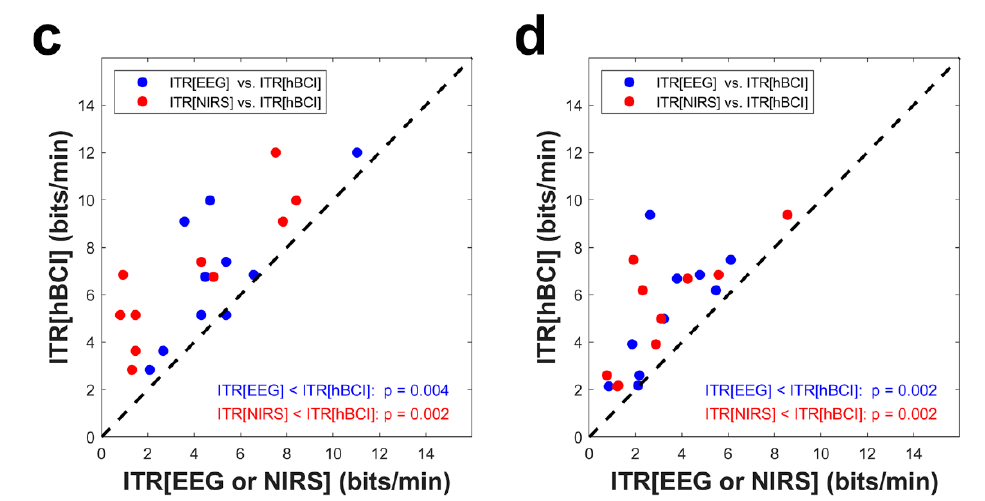
Figure 7. Comparison of the ITRs as a function of the classification accuracy: ( a ) MA vs. BL and ( b ) WC vs. BL. The scatter plots comparing the ITRs of the EEG or NIRS verses those of the hBCI (blue: EEG vs. hBCI and red: NIRS vs. hBCI) for ( c ) MA vs. BL and ( d ) WC vs. BL. In ( c , d ), the circles above the black dashed lines indicate that the individual ITRs of the hBCI are higher than those of the EEG or NIRS. The p -values indicate the significance.